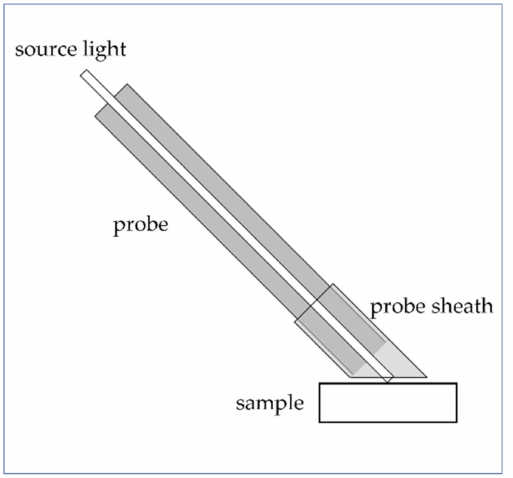
Figure 1. FORS probe with a small cylindrical sheath to exclude external source of